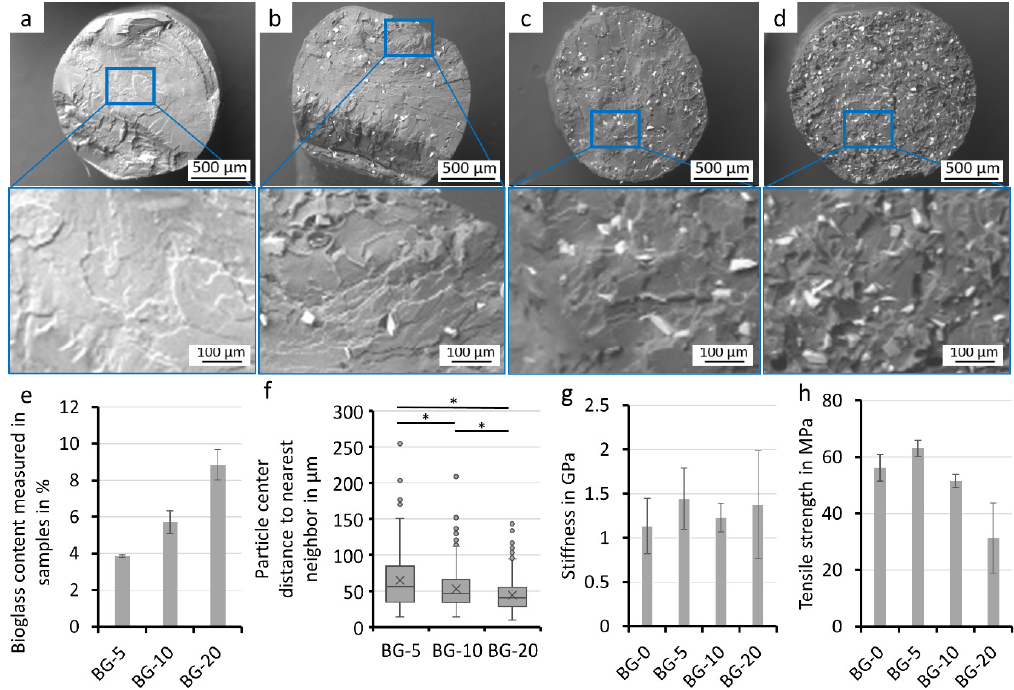
Figure 2. Analysis of the composite filament. SEM-Images of the custom-made PLA-bioglass composite filaments and their close-ups: BG-0 ( a ), BG-5 ( b ), BG-10 ( c ), BG-20 ( d ). The PLA matrix is visible in grey; bioglass particles in white. The area of bioglass particles in the cross section was analyzed via a threshold, and bioglass weight in the filament was calculated using the specific densities of PLA and bioglass (Means ± SD, n = 3) ( e ). Distance between bioglass particle centers and their nearest neighbor is shown (two samples per bioglass content with at least 231 particles were analyzed, * indicates significant differences of p < 0.05) ( f ). Stiffness ( g ) and tensile strength ( h ) of the custom-made filaments are presented (Tensile Testing, Means ± SD, n = 3).